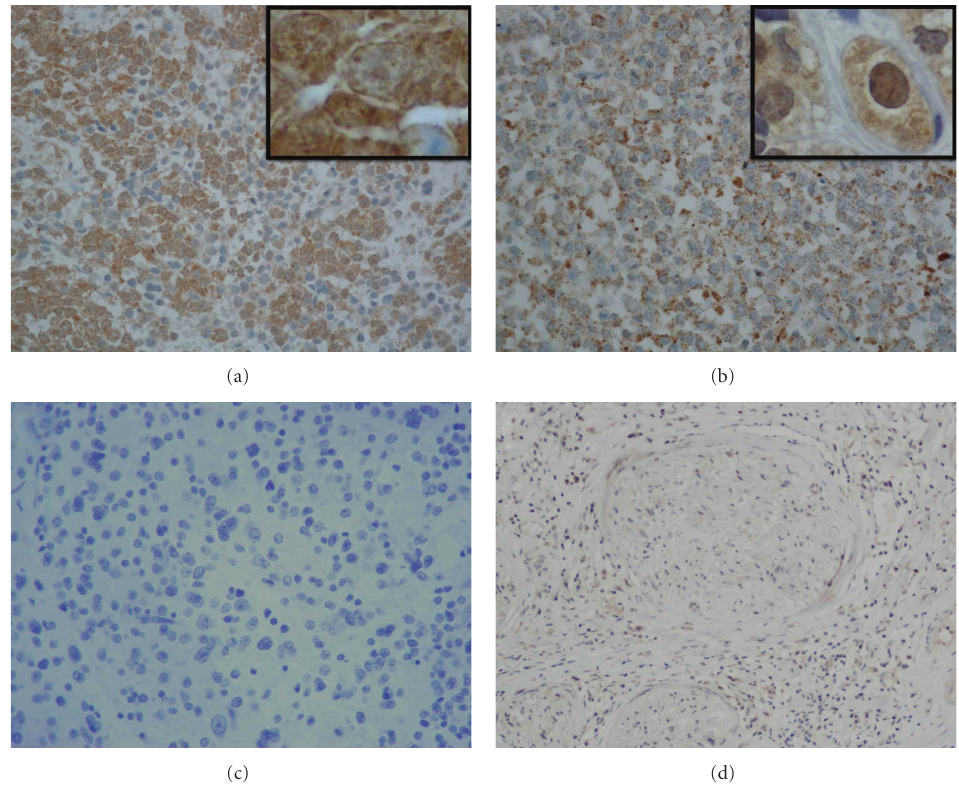
Figure 1: Immunohistochemical detection of NeuGc-GM3 ganglioside in neuroectodermal tumors. (a) Neuroblastoma (NMYC-amplified). (b) Ewing sarcoma family of tumors (ESFT). (c) Negative isotype control staining (mouse IgG1) in neuroblastoma. (d) No expression in nontumoral neural tissue. Original magnification 400X (a, b and c), 100X (d), 1,000X (insets).